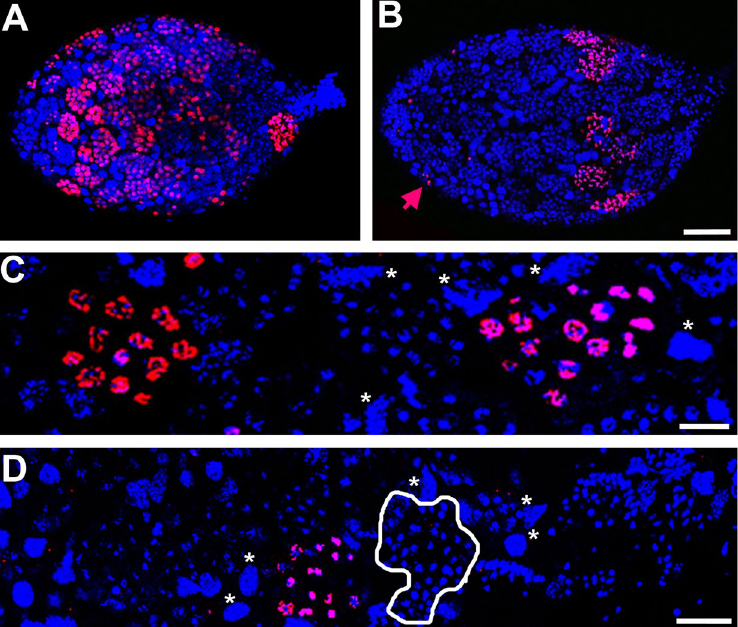
Figure 2. Spermatogonial division is asynchronous across different cysts. ( A ) A testis from a white/yellow body pupa containing numerous cysts with germ cells undergoing division, as indicated by the presence of H3S10p (red). ( B ) A testis from a yellow body-red eye pupa containing a narrow region of cysts with germ cells undergoing division. The germ cells of most cysts in this testis are not undergoing division. However, a few single cells at the testis anterior appear to be dividing (red arrow). ( C ) A high magnification of a region within a testis containing two cysts undergoing division. Resolved chromosomes can be seen with high levels of H3S10p. ( D ) A high magnification of a region within a testis containing one cyst with germ cells undergoing division, in addition to several cysts with round, condensed nuclei and no H3S10p, indicating entry into spermiogenesis. Circumscribed cystocytes have condensed nuclei but are not H3S10p-positive, indicating that they have entered into spermiogenesis. Asterisks in ( C , D ) indicate some of the trophocyte nuclei. DNA is blue in all panels. Scale bar equals 40 μ m in ( B ), 6 μ m in ( C ), and 10 μ m in ( D